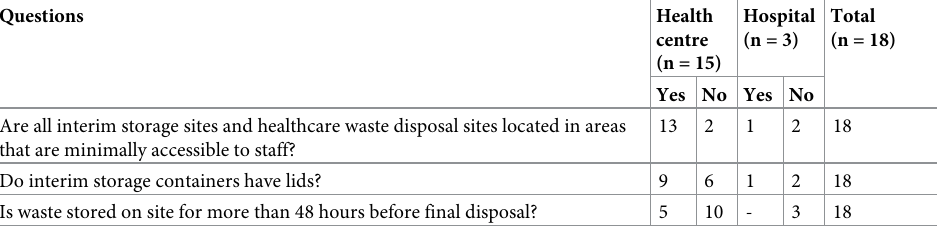
Table 14. Interim storage for HCW observed in the study health facilities, Addis Ababa City Administration, Feb- ruary